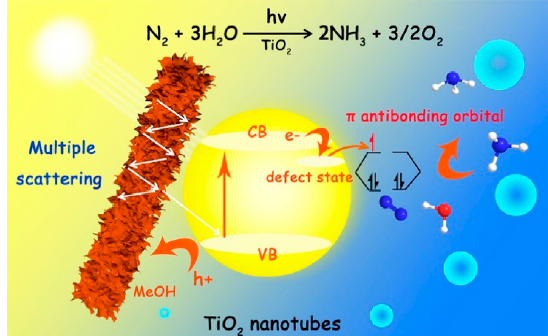
Figure 19. Photocatalytic nitrogen fixation mechanism by TiO 2 (B) nanotubes. Reprinted with permission from [274].